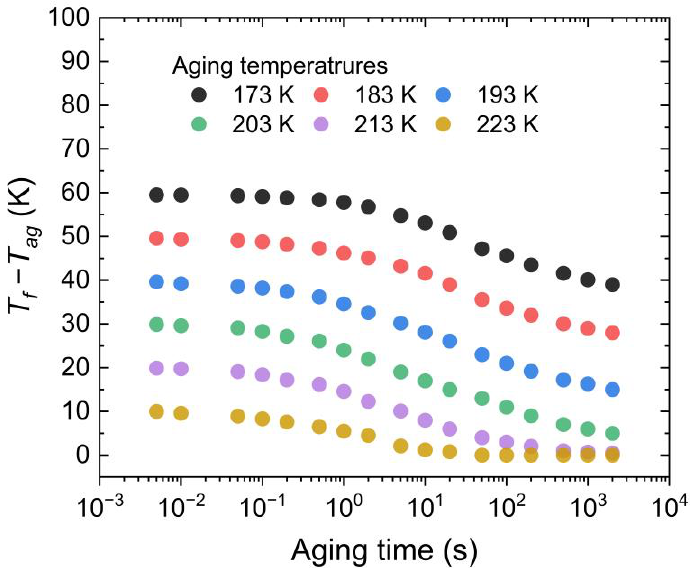
Figure 6. Evolution of T f taken as the distance from T g,γ with the aging time for PBTTT aged at indicated adding temperatures.